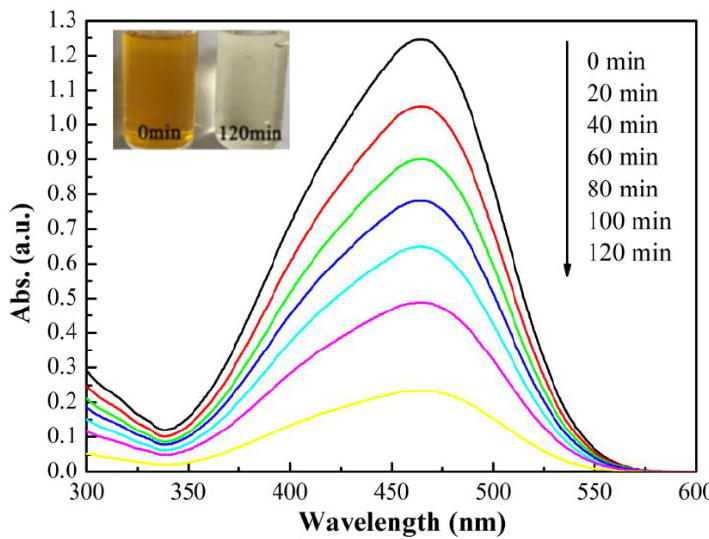
Absorbance changes in methyl orange (20 mg/L) on the Y 2 O 3 /TiO 2 -loaded polyester fabric.